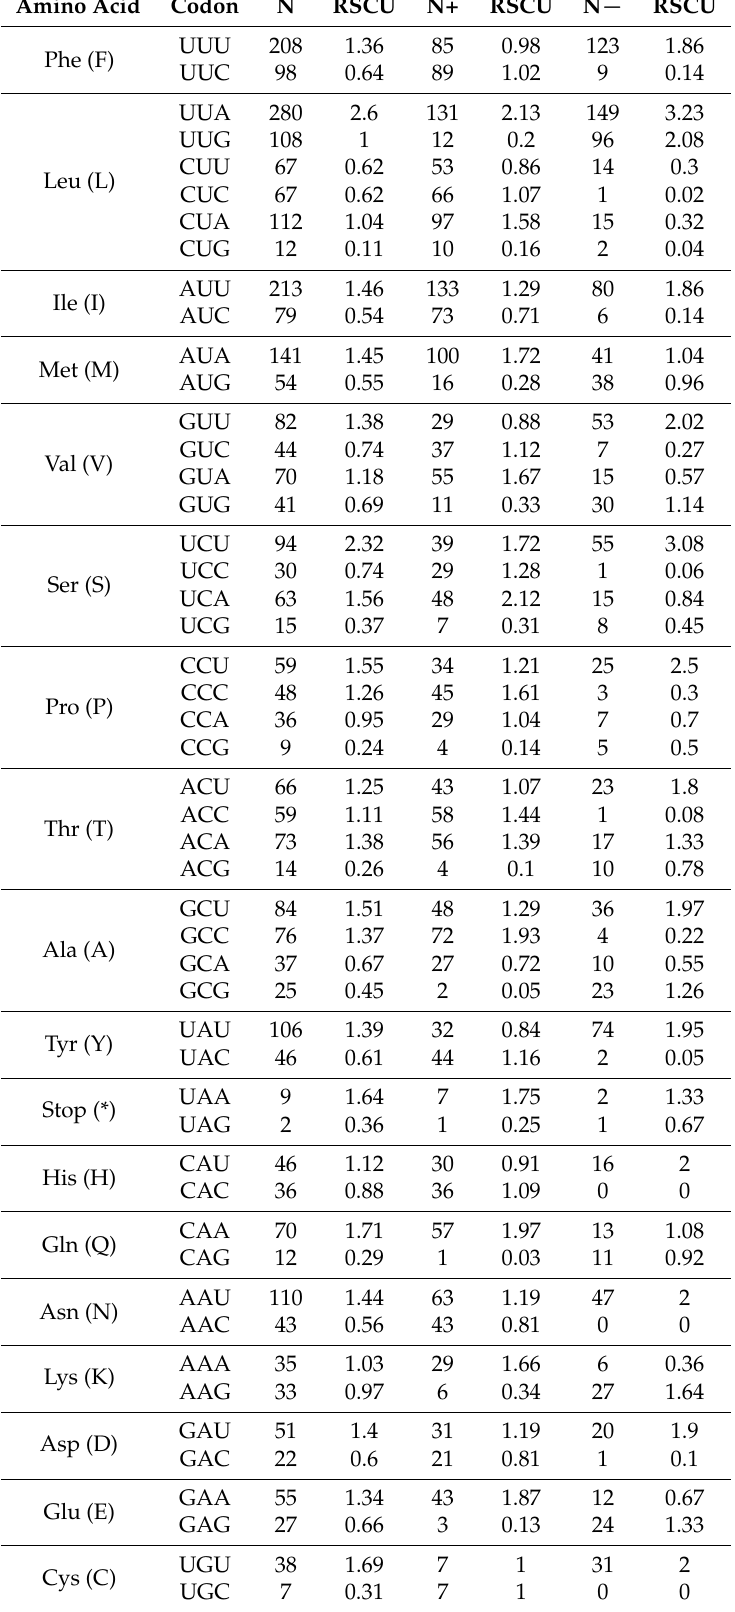
Table 4. Codon usage of S. teleckojensis mitochondrial genome protein-coding